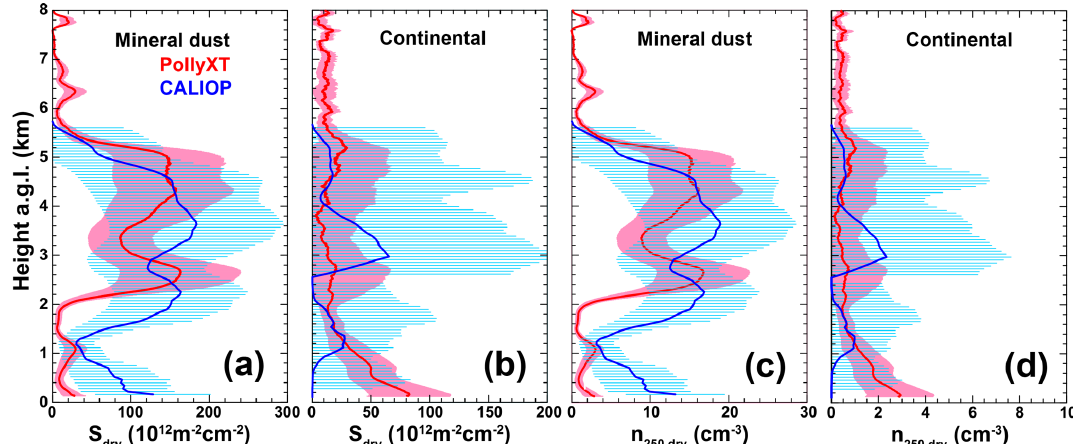
Figure 6. Profiles of the surface (a, b) and number concentrations (c, d) of mineral dust (a, c) and continental particles (b, d) with a dry radius larger than 250nm derived from measurements with PollyXT between 01:00 and 02:00UTC on 21 April 2016 (red) and retrieved from averaging 160km of CALIOP measurements centered around an overpass at a distance of 5km from Nicosia at 11:01UTC on 21 April 2016